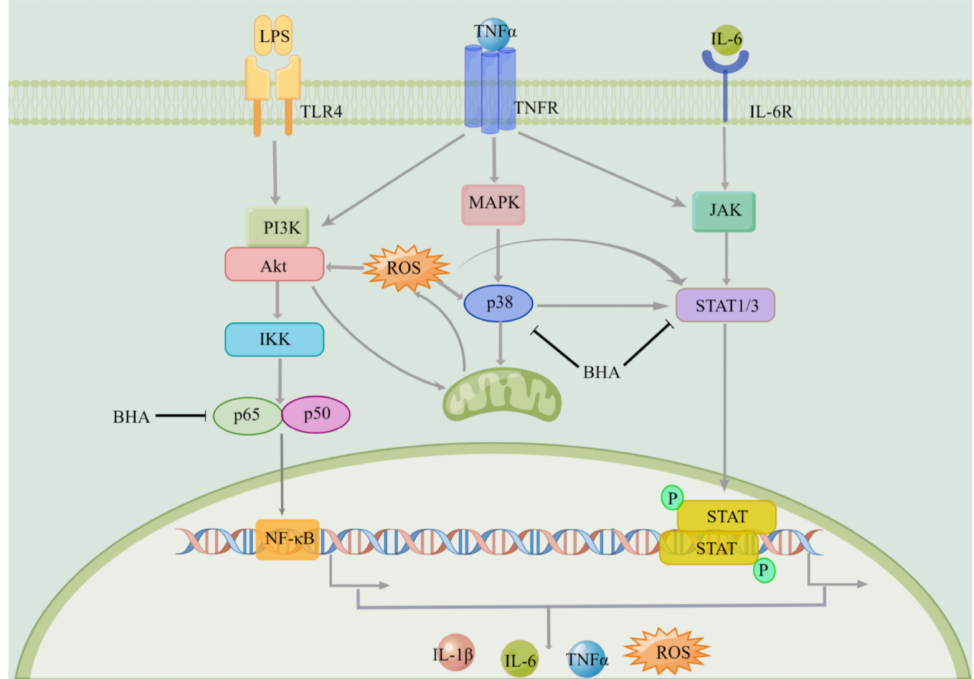
Figure 7. Anti-inflammatory effects of BHA and the mechanism of action. BHA interact with TLR4, interfering the expression of p65, p38 and STAT1/3, reducing the level of ROS and the production of cytokines TNF α , IL-1 β and